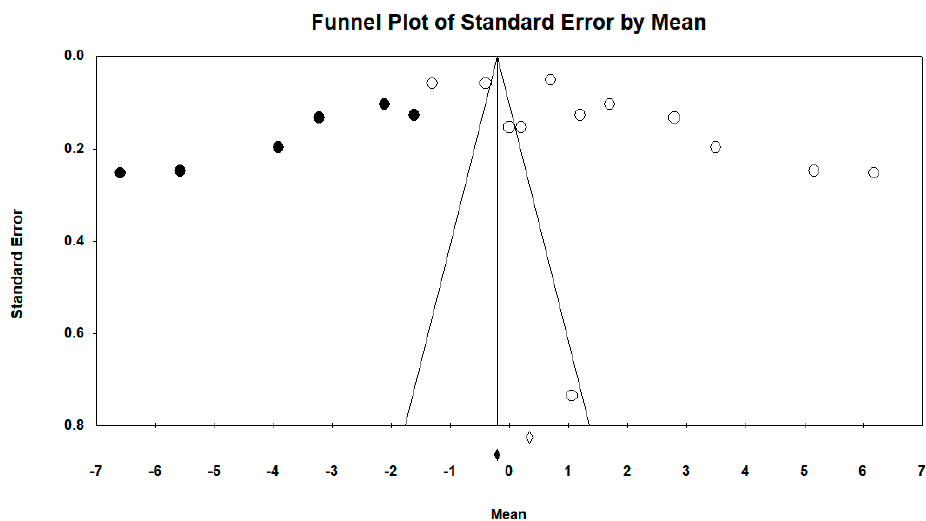
Figure 8. Funnel plot diagram of the standard error ( y -axis) and the SMD ( x -axis), after incorporating the Duval and Tweedie “trim and fill” procedure: difference between groups in the intervention group with resistance therapy on the GMFM scale in all follow-ups.